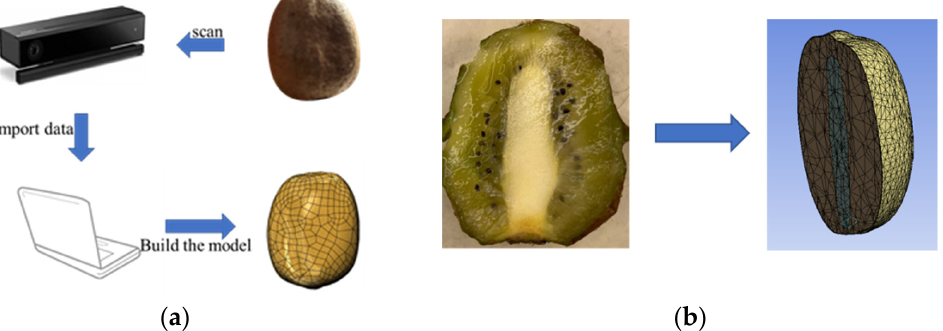
Figure 2. The kiwifruit three-dimensional model. ( a ) Model building process; ( b ) Cross-sectional view of kiwifruit.